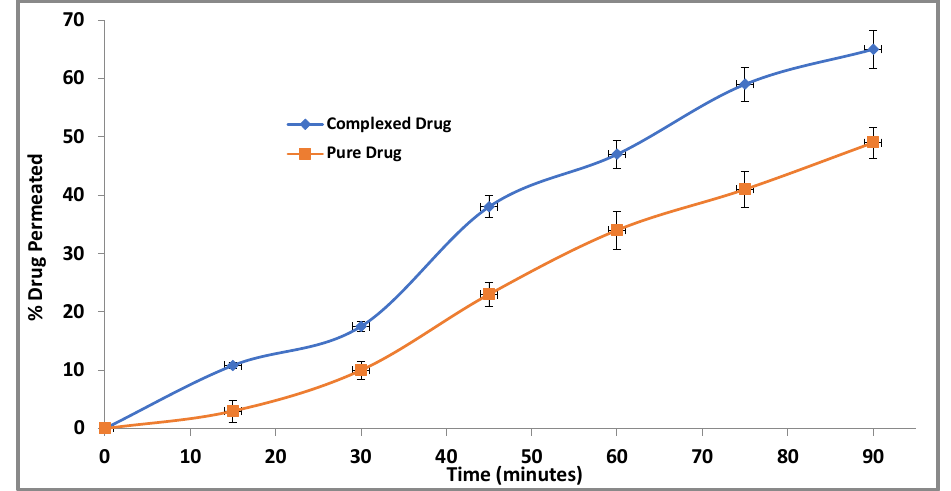
Figure 6. Ex vivo permeation profile of the pure drug and the complexed drug across the rat intestinal sac.